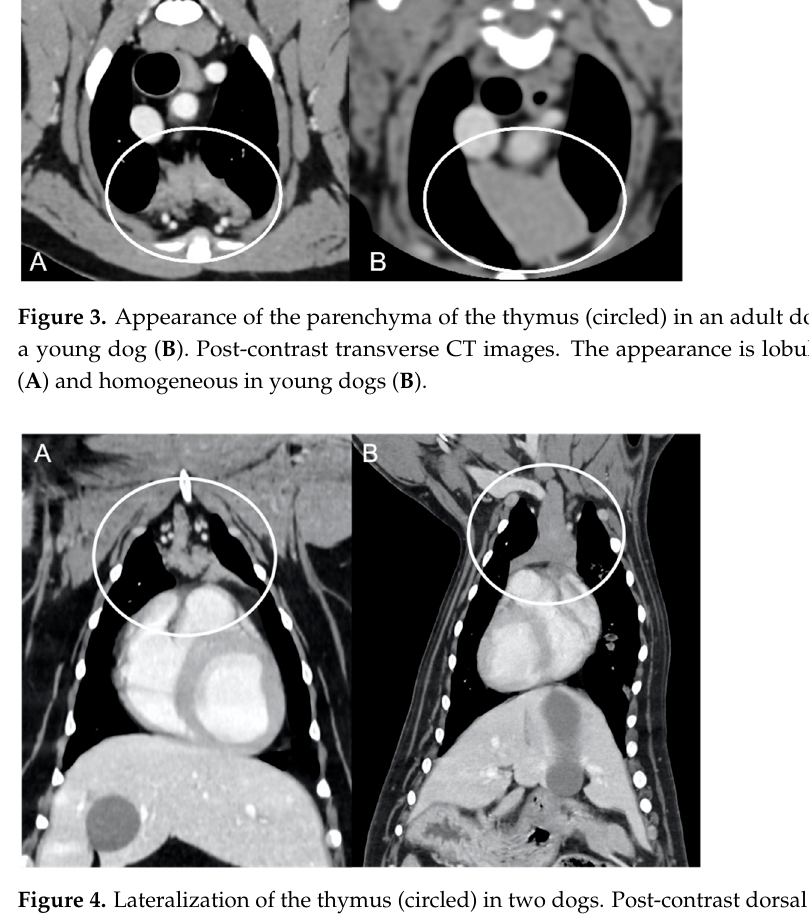
Figure 4. Lateralization of the thymus (circled) in two dogs. Post-contrast dorsal CT reconstructions. A mainly left-sided thymus in an adult dog ( A ) compared to a mainly right-sided thymus in a young dog ( B ) with situs inversus.